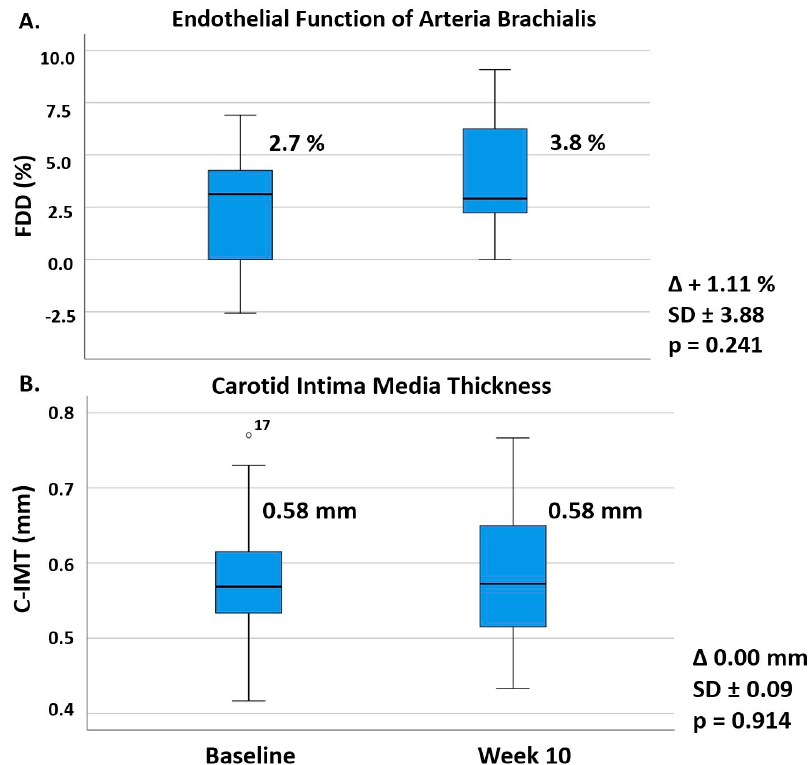
Figure 2. Effects of Alirocumab on Established Ultrasound-based Vascular Parameters. Legend: The numerical data shows mean values at baseline and after 10 weeks of alirocumab treatment with mean change, standard deviation, and p -value, while boxplots graphically represent medians and interquartiles. The small circle with the number 17 at the left upper side of the figure identifies an outlier measurement of patient number 17 at baseline. Outliers are defined as values between 1.5x and 3x interquartile ranges from the end of a box. Trial-completion analysis with two valid assessments for statistical analysis (n = 18); Paired t-test with a two-sided p -value. ( A ) Flow-dependent dilatation (FDD) of the arteria brachialis. ( B ) Carotid intima-media thickness (C-IMT) of the vessel wall.